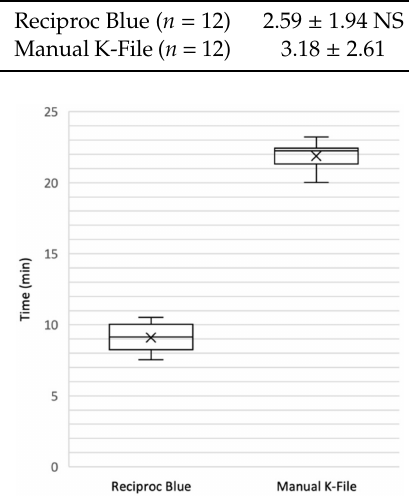
Table 3. Radiopaque remaining filling materials (remnants) visible in periapical radiographies and expressed as area with residual radiopacity (mm2; mean ± SD).